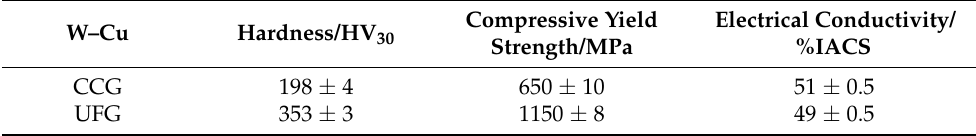
Table 1. Properties of the CCG W–Cu and UFG W–Cu